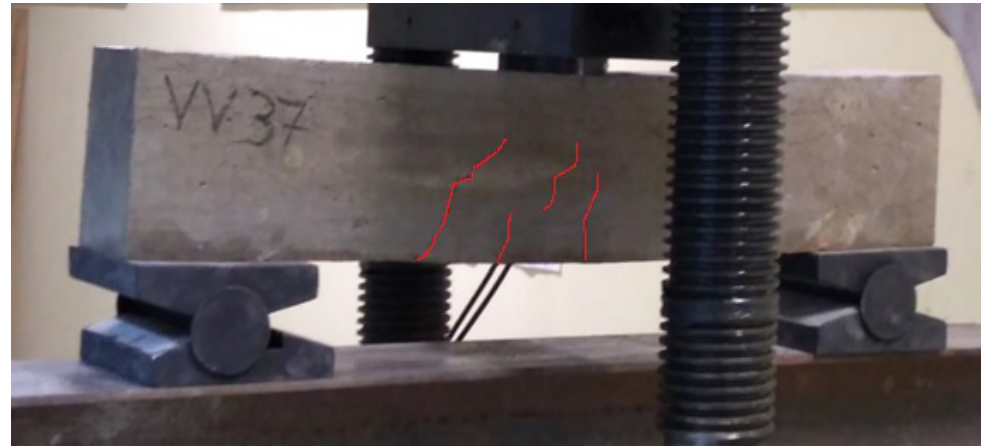
Figure 9. Cracks observed in beam